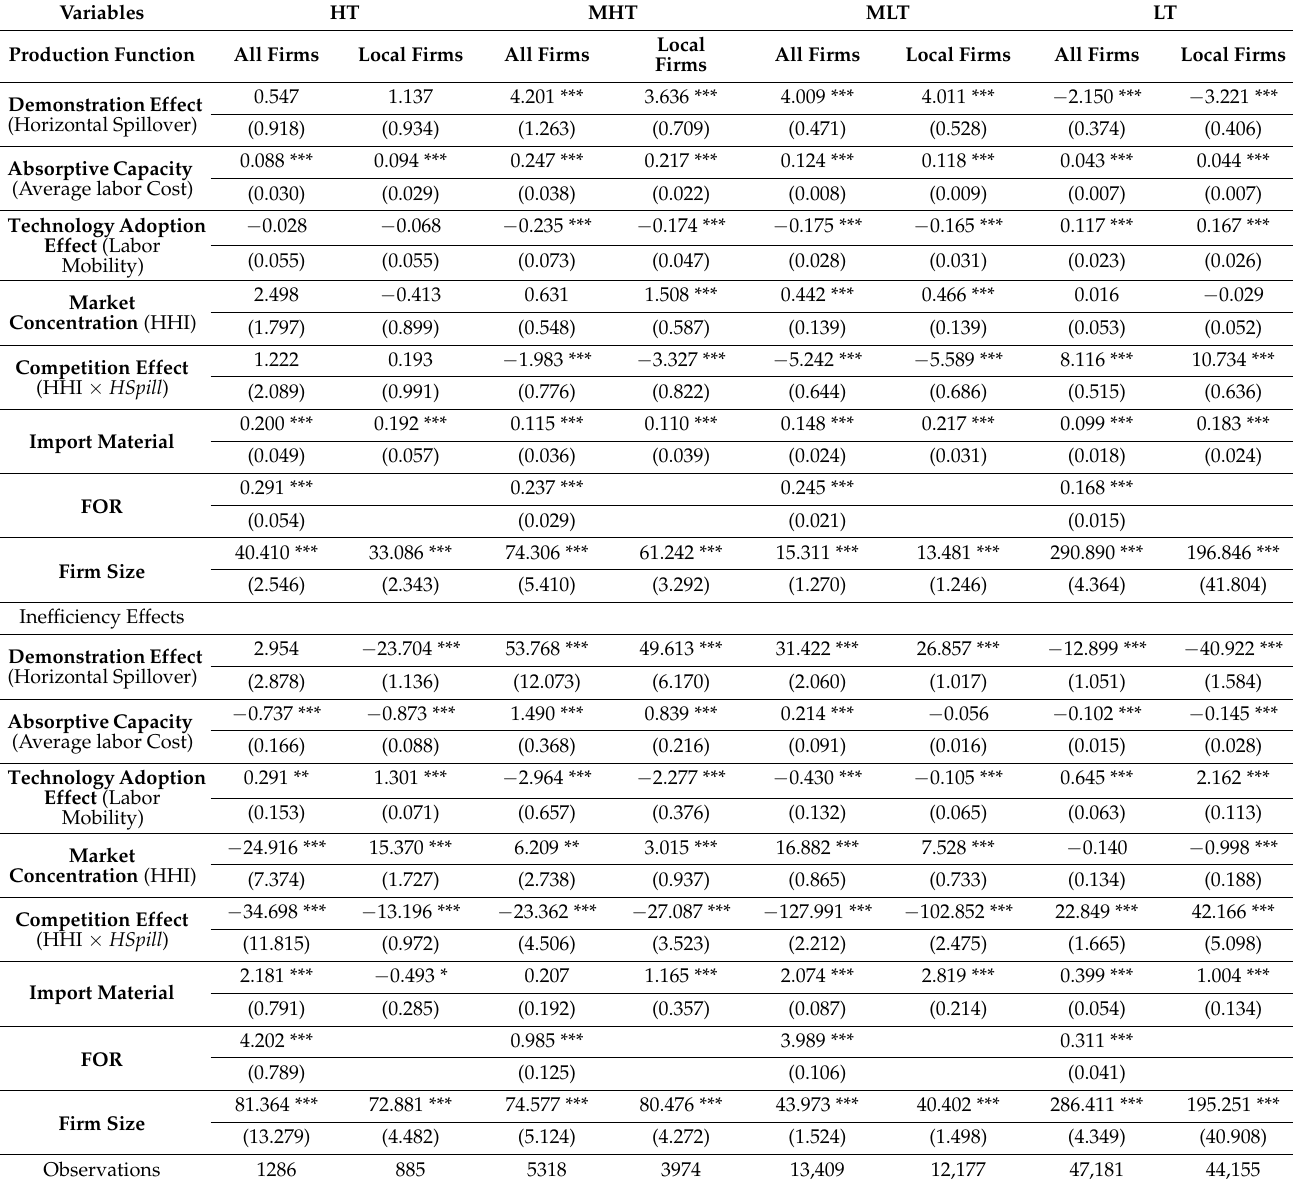
Table 5. The estimation of stochastic production